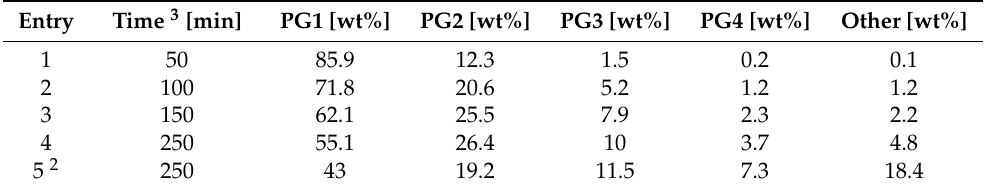
Table 3. Microwave-assisted continuous oligomerization of glycerol with peristaltic pump in cyclic mode (GC analysis) 1 .